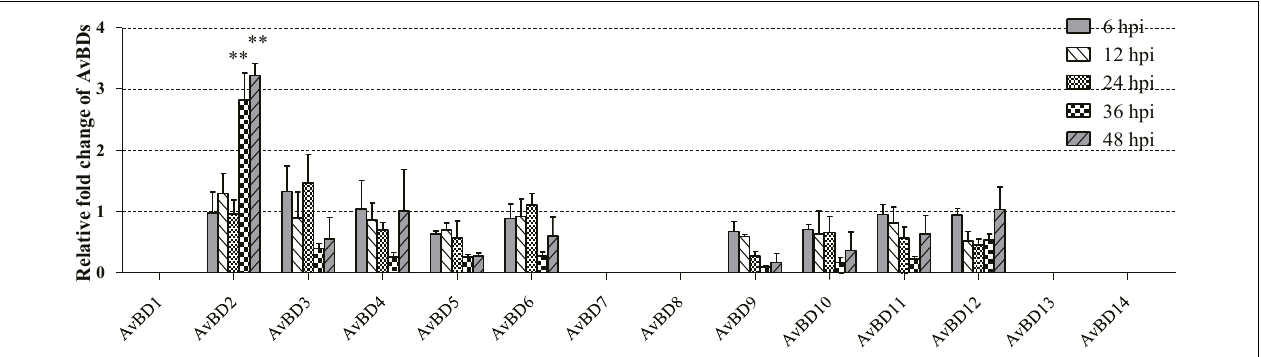
FIGURE 2 | Relative gene expression of AvBDs in response to NDV infection in CEFs. Fold change of mRNA expression in CEFs of each group were measured by RT-PCR at 6, 12, 24, 36, and 48 hpi, respectively. Transcript levels of AvBDs were normalized to 18S rRNA and mRNA expression is shown as the fold change relative to the control. All assays were performed in triplicate, and each bar is the mean ± SEM. Statistically significant differences between groups are indicated by ∗ p < 0.05 or ∗∗ p < 0.01.